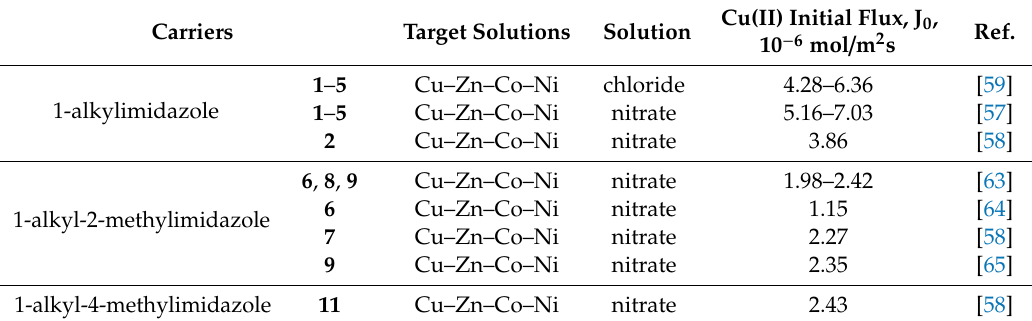
Table 6. An example of the transport of Cu(II) ions across PIMs doped with alkylimidazole derivatives from chloride or nitrate solutions reported in the